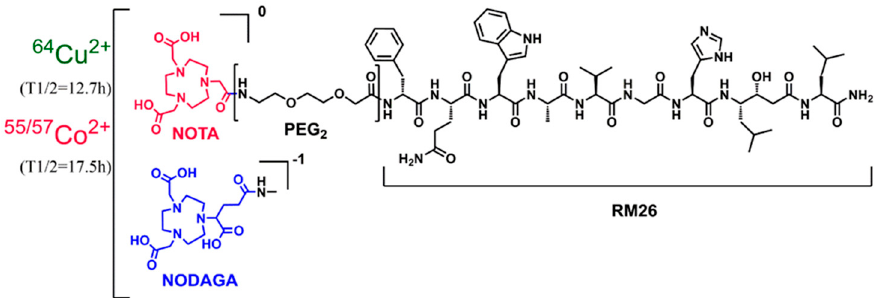
Figure 1. Schematic overview of the structure of [ 64 Cu]Cu- and [ 55 Co]Co-labeled X-RM26 (X = NOTA-PEG 2 , NODAGA-PEG 2 ).